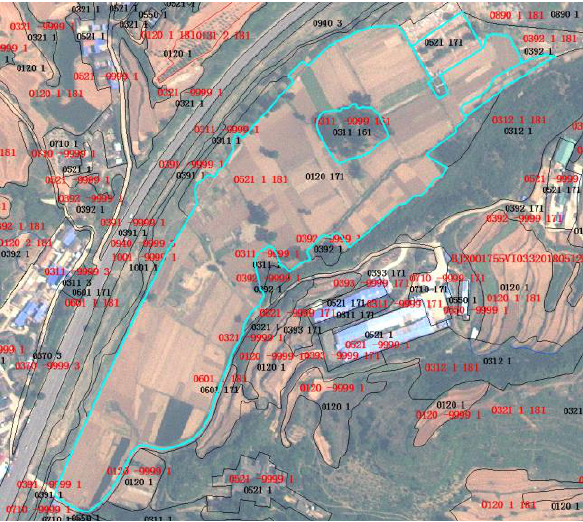
Figure 4. The dry land(0120) was incorrectly updated as a housing construction area(0521) .